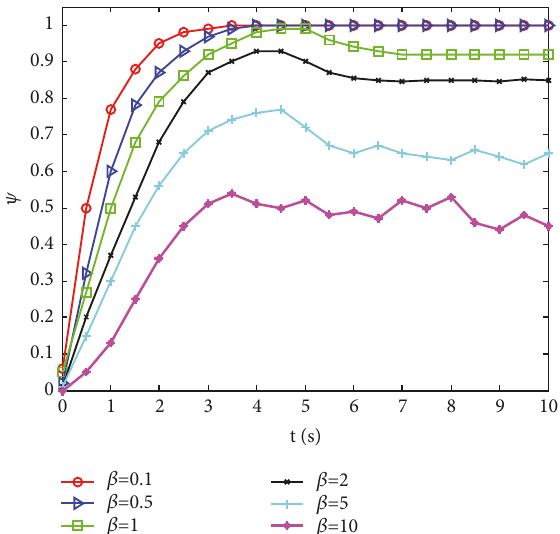
Figure 11: Thedifferentiation indexof flockingsystem with different 𝜅 𝑖𝑗 .